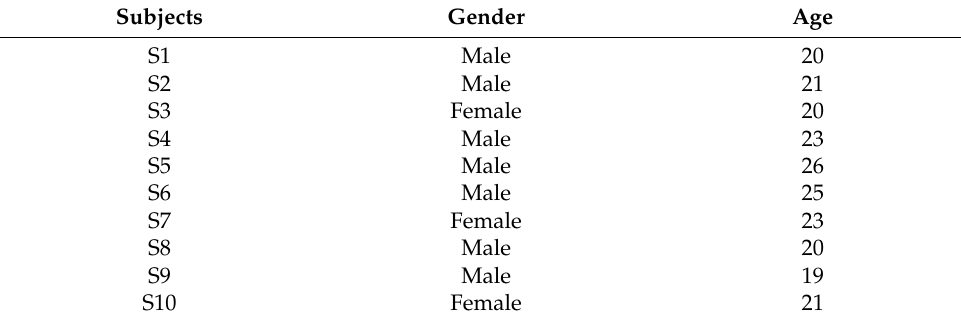
Table 1. Basic information of the